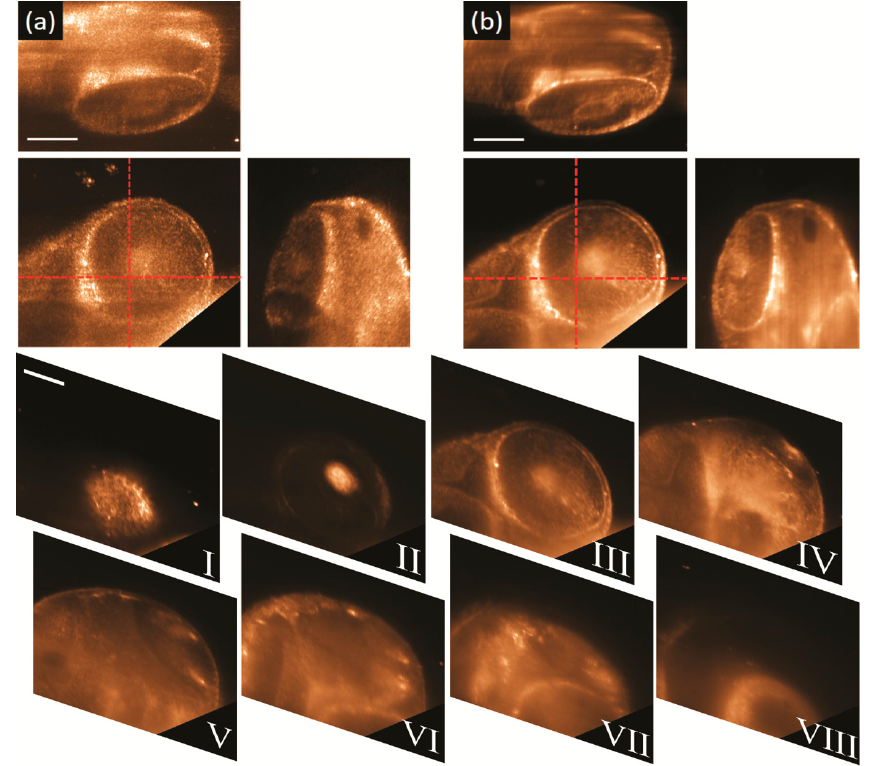
Figure 5. 3D elastic scattering light sheet microscopy of the head of a 48 hpf zebrafish embryo. Polarization was set to horizontal-IN horizontal-OUT configuration. 3D orthogonal views (center panel front-view, top panel top-view, right panel side-view) of the data taken with: ( a ) a high coherence (638nm) diode laser and a static illumination light sheet, and, ( b ) a low temporal coherence SCL emitting a broadband spectrum of 140nm (centred at 600nm) and with the light sheet pivoting at 100Hz with respect to the centre of the FOV. Corner cut in the front views were made to remove the intense scattering signal coming from the embryo’s yolk. From panels I to VIII, stack of eight consecutive sections separated each other 40 μ m. Laser power at the back of OBJill is 1 mW for both datasets. Scale bars 100 μ m.